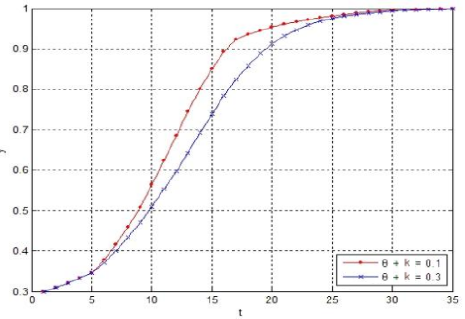
Figure 8. The influence of (θ + k) changes on the probability of enterprise construction waste emissions reduction, y.